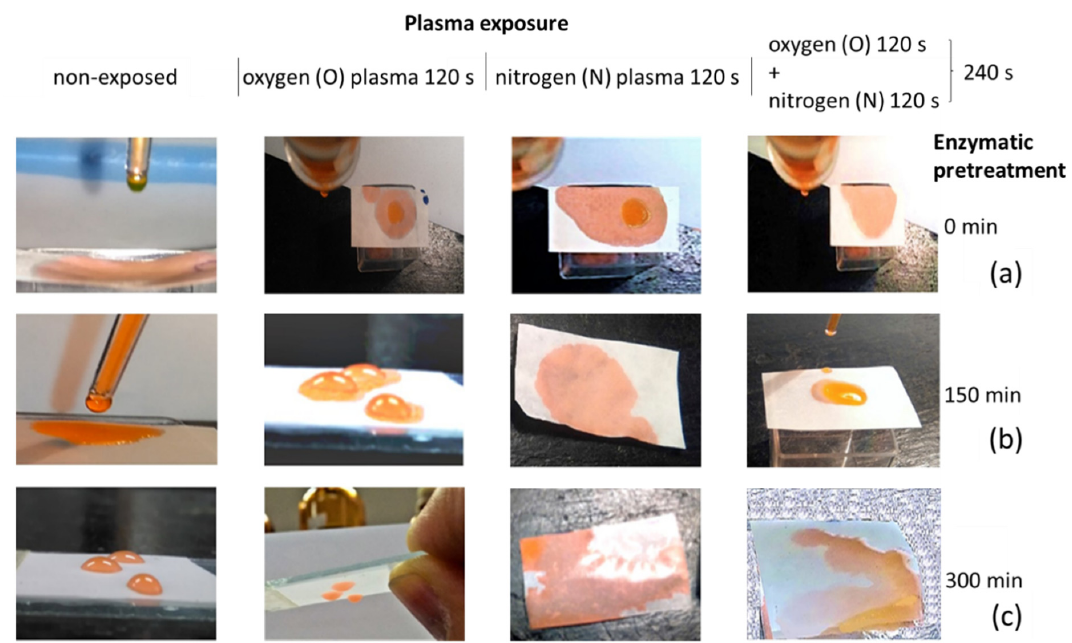
Figure 16. Wetting experiment with drops of dyed water (Eosin dye 0.5%) with different regimes of gas plasma exposure, O